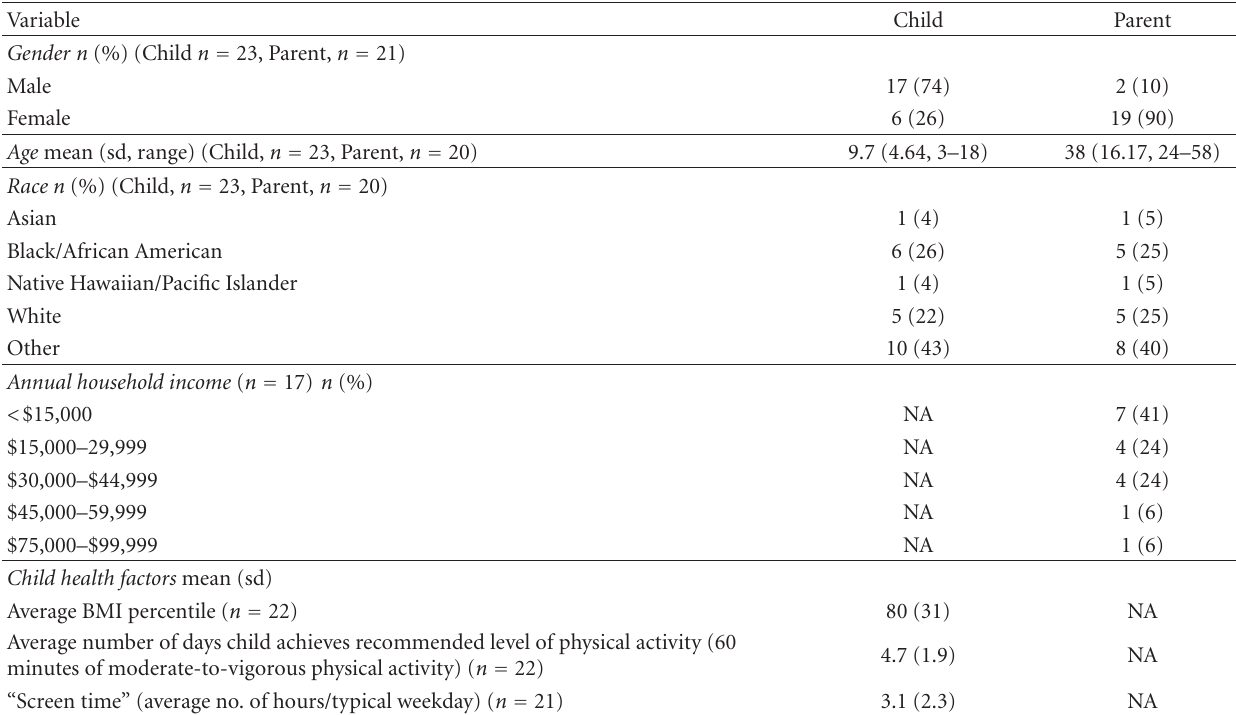
Table 1: Parent/guardian and child demographics.